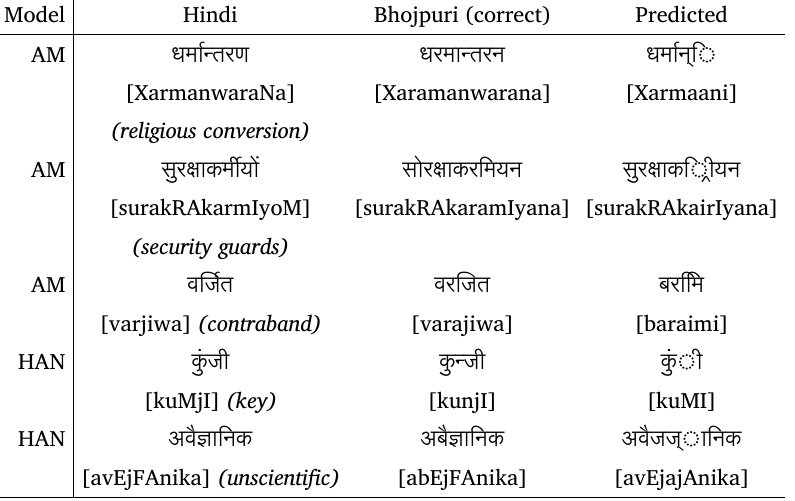
Table 15: Phonetically/orthographically invalid translations: for invalid predic- tions, a closest approximation of the WX notation is given